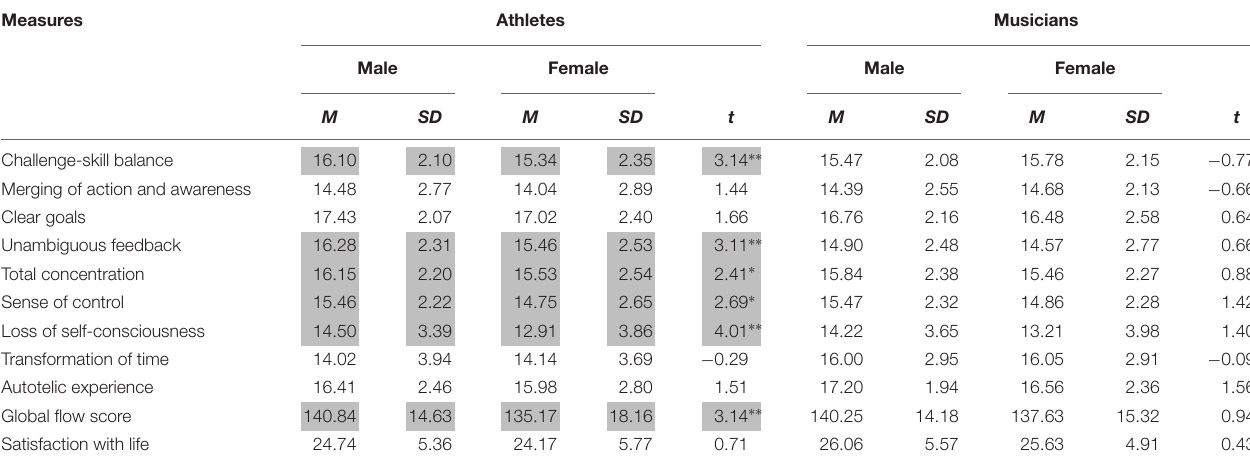
TABLE 5 | Comparison of male and female musicians and athletes in flow dimensions and satisfaction with life. Measures Athletes